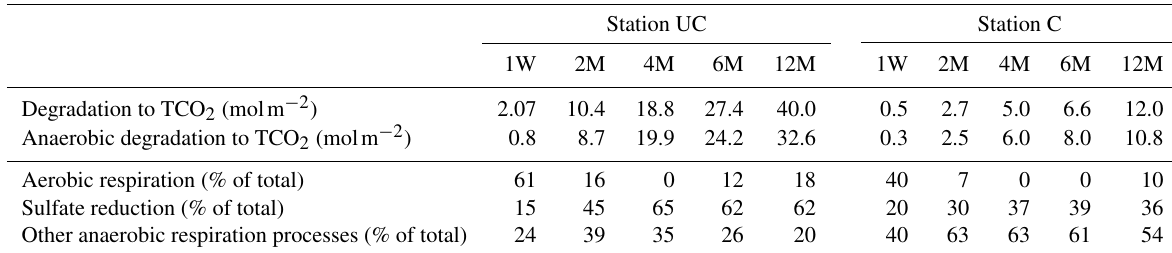
Table 3. Budget table showing cumulated time-integrated total degradation to carbon dioxide (TCO 2 ) in flooded uncultivated (UC) and cultivated (C) soil, based on TCO 2 fluxes and total anaerobic TCO 2 production based on jar experiments. Estimated partitioning between aerobic respiration, sulfate reduction and other anaerobic respiration processes is also shown. Different times after flooding are indicated by 1W (1 week) and 2M, 4M, 6M and 12M (2, 4, 6 and 12 months,